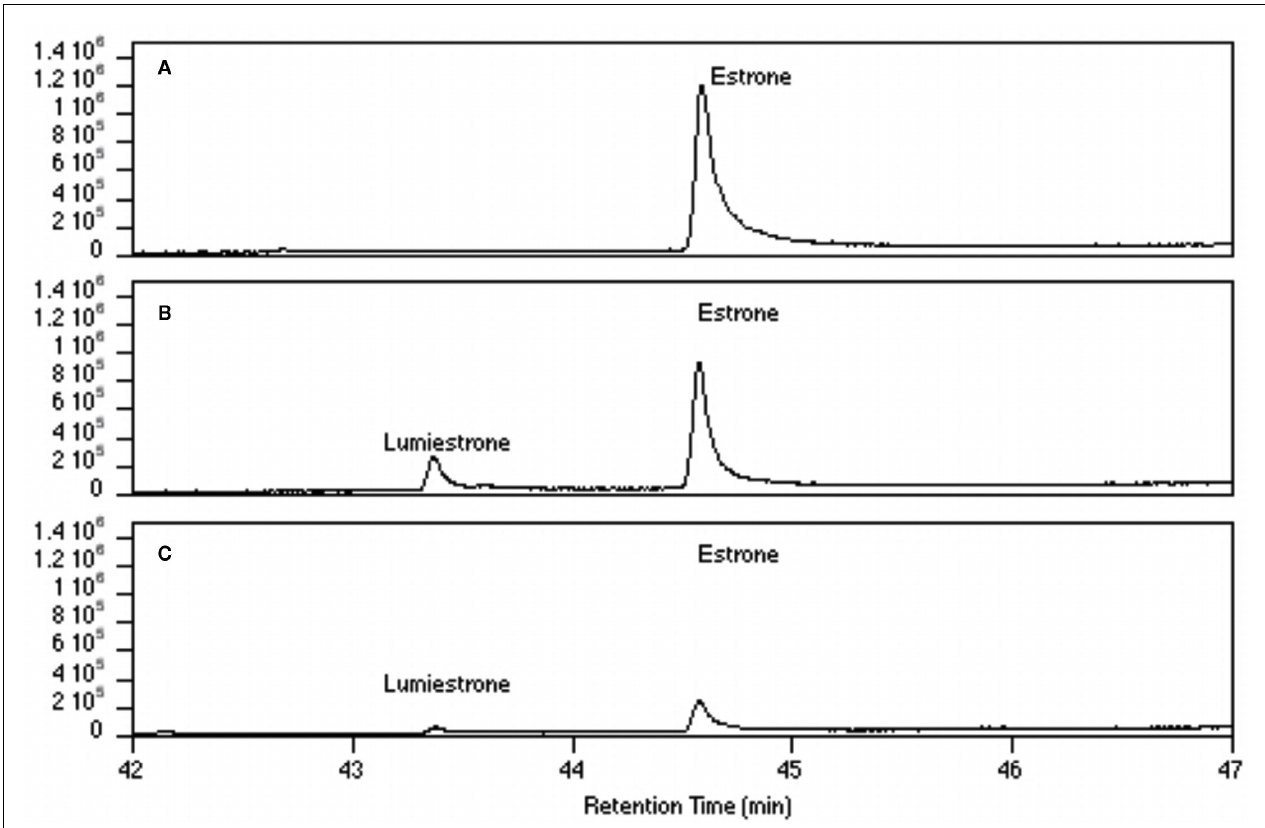
FIGUREA2 | Conversion of estrone into lumiestrone in water (ethanol < 1%) following exposure to UV-B radiation followed by gas chromatography. Irradiation times were (A) 0min, (B) 15min, (C) 45min.